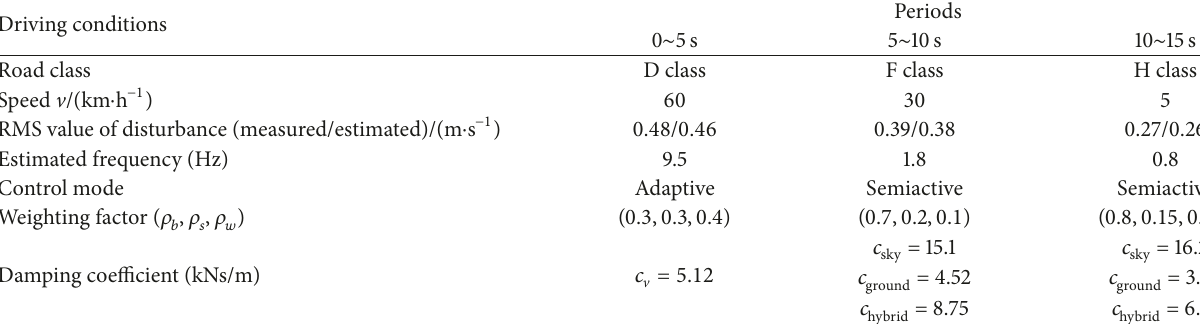
Table 5: The input disturbances estimation and the optimization results.